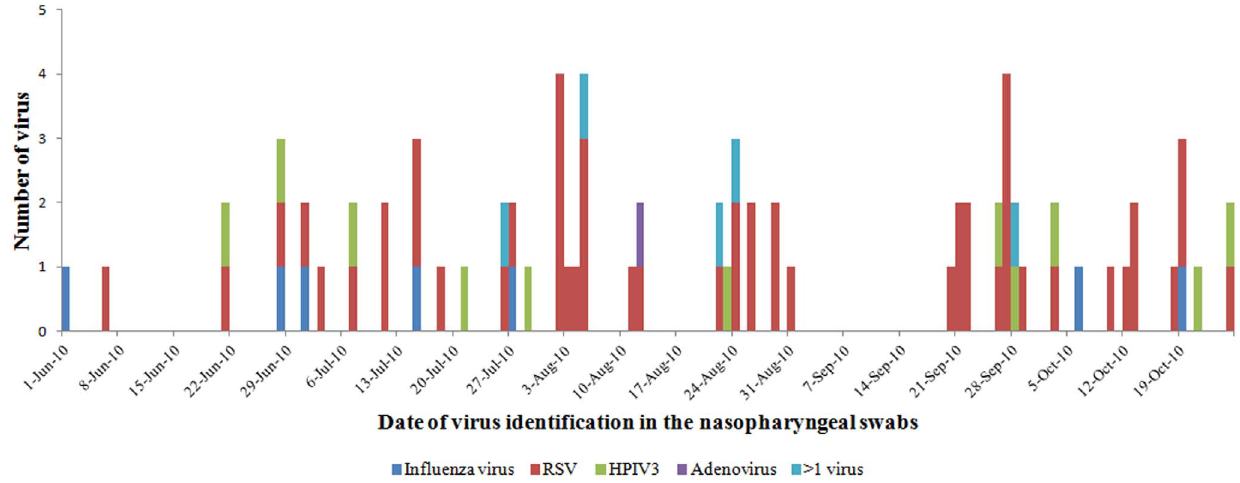
Figure 2. Respiratory viruses identified among children aged , 5 years with severe acute respiratory infections during the typical influenza epidemic period in Bangladesh rainy season, 2010.